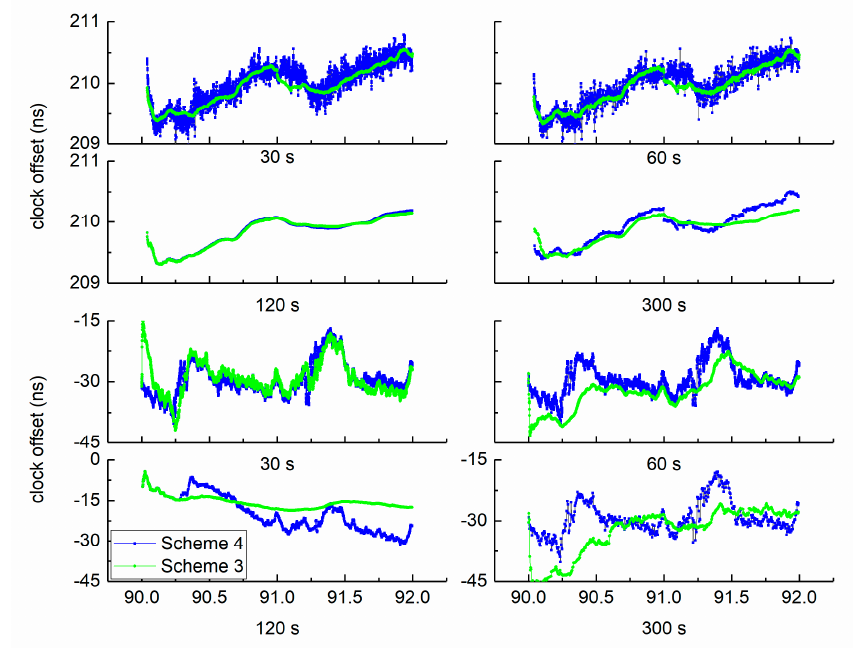
Figure 8. The clock offset of stations BRUX and GMSD on DOY 90-91.